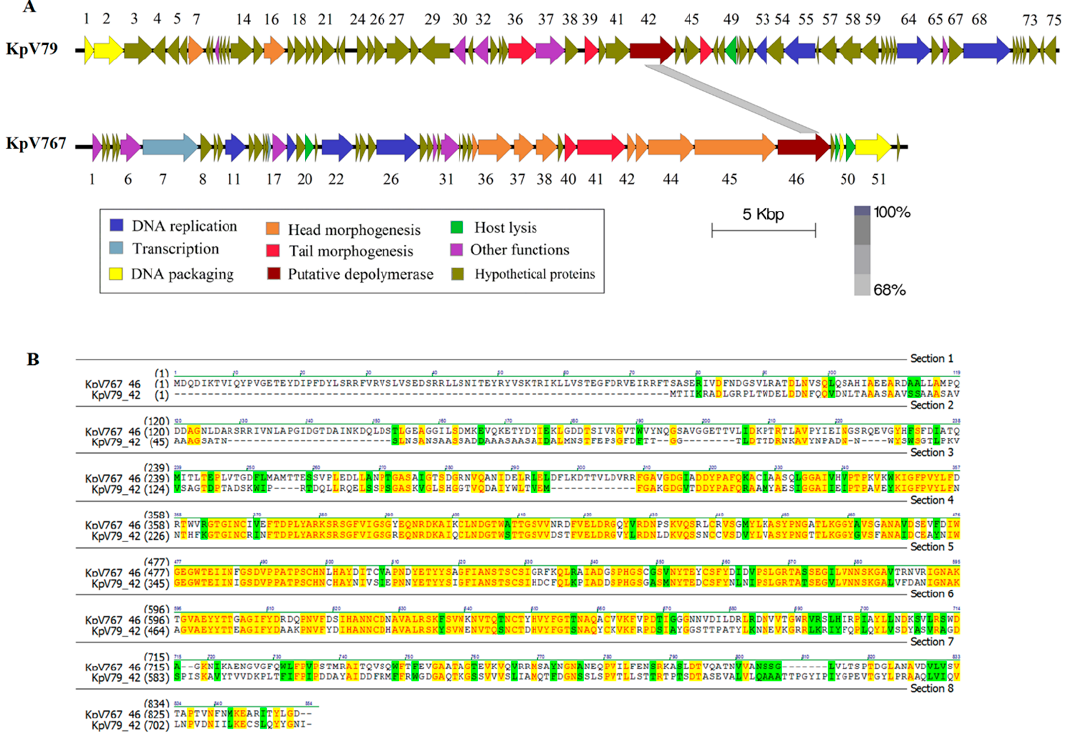
Figure 2. Genomic analysis of bacteriophages KpV79 and KpV767. ( A ) Open reading frame organization and comparison of phages genomes. ( B ) Comparison of amino acid sequences encoded